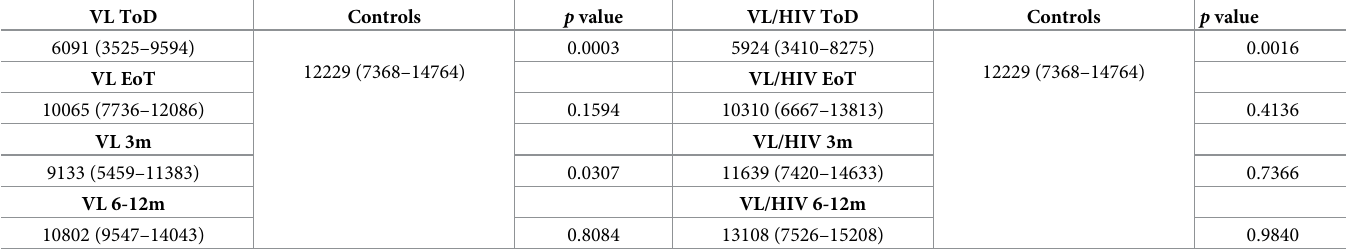
Table 3. Comparison of neutrophil CD62L expression levels between VL and VL/HIV patients and controls over time. VL